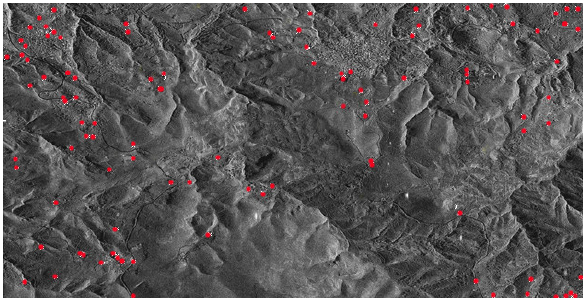
Figure 8: The distribution of the CPs on the SSC TerraSAR-X image.